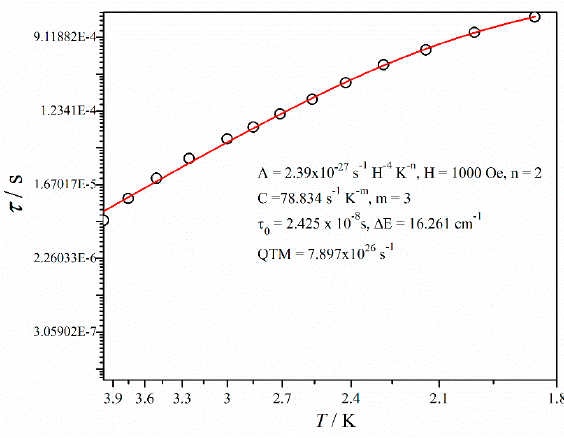
Figure 4. Temperature dependence of relaxation time for complex 1’ .